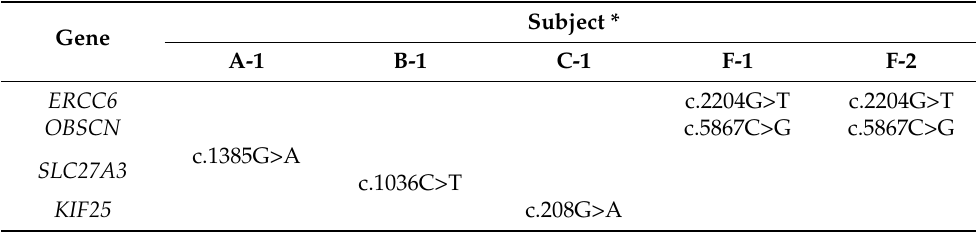
Table 2. Candidate gene variants found in variant-positive patients. Gene